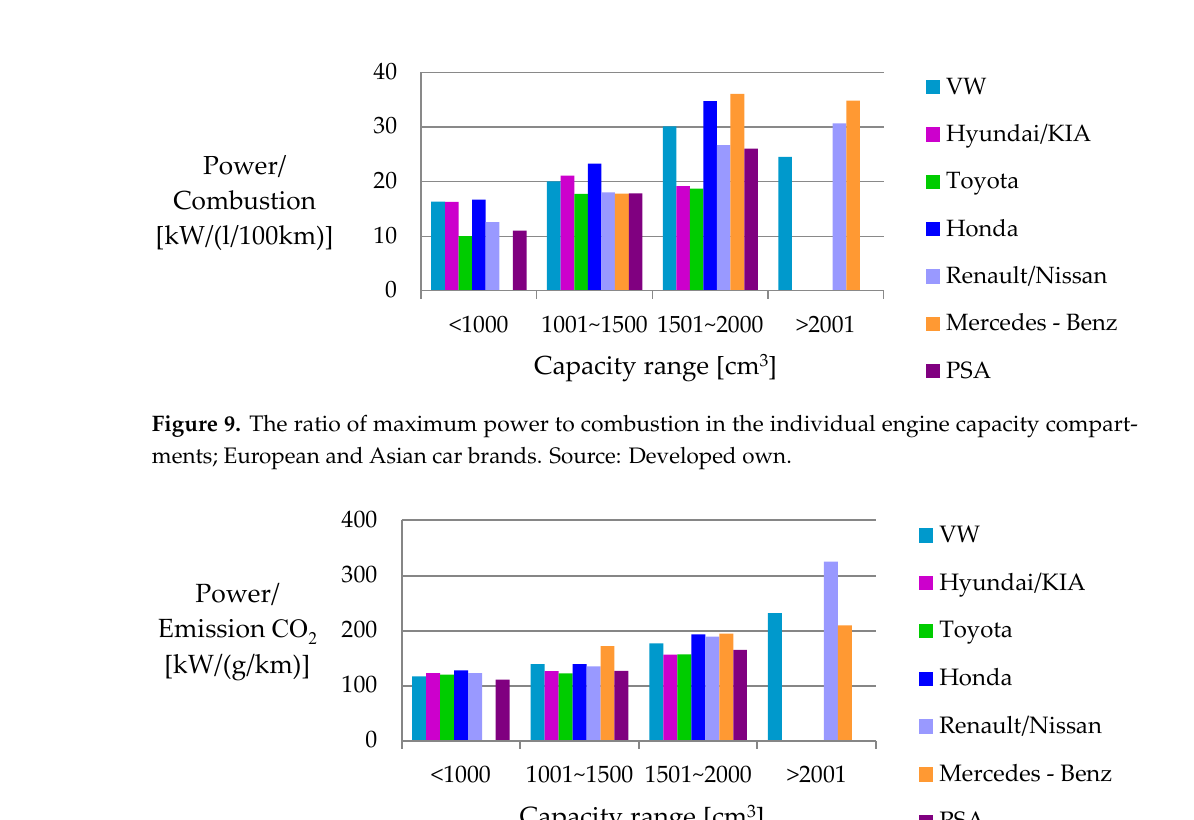
Figure 8. The ratio of engine capacity to emissions in each capacity compartment; European and